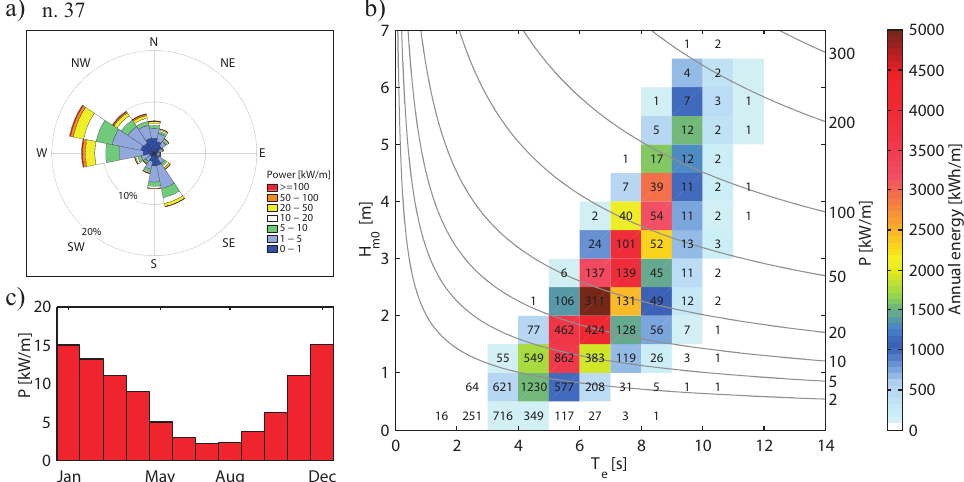
Figure 6. Characterisation of mean yearly wave energy and wave energy flux climate at point n. 37; in ( a ), the wave energy flux rose; ( b ) the scatter plot of H m e T e , the colour scale indicates annual 0 energy per meter of wave front (kWh/m), the numbers within the bins indicate the occurrence of sea states (hours/year) and the isolines specify the wave energy flux; ( c ) the histograms of the monthly mean wave energy flux.